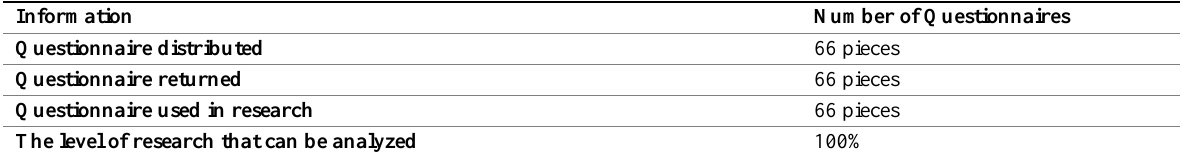
Table 2: Distribution and Return Details